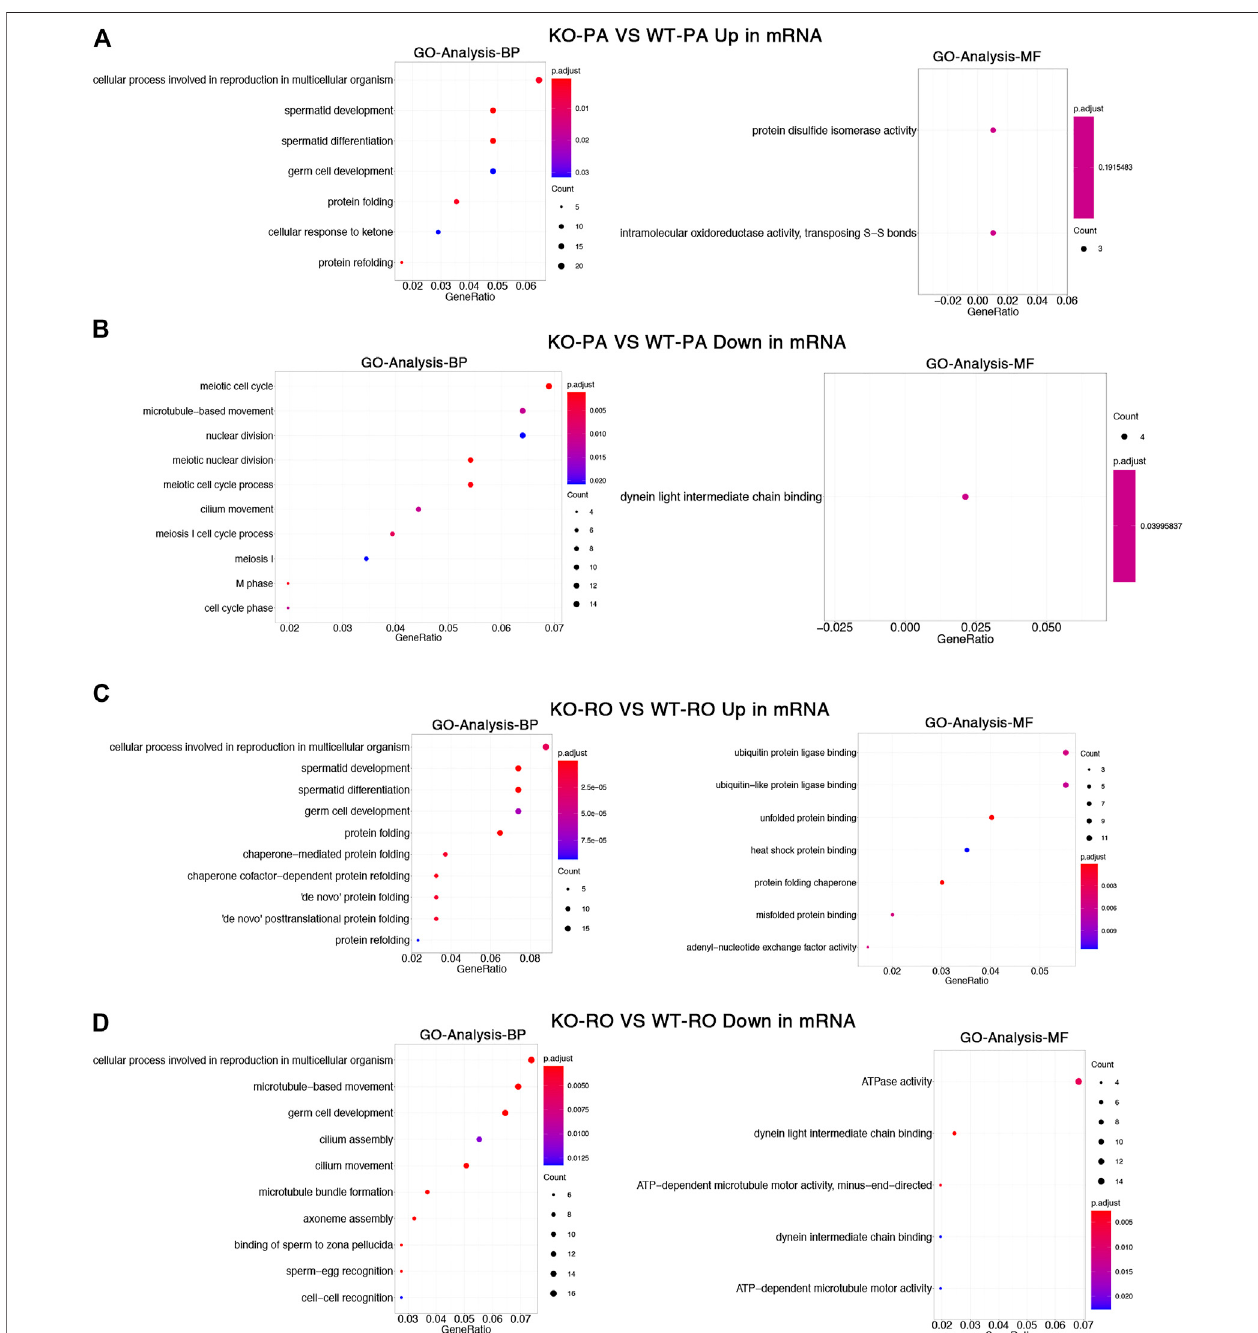
FIGURE5| GOenrichmentanalysisofupregulated (A) and downregulated (B) genesbetween Alkbh5 -KOPAand WTPA.GOenrichmentanalysisofupregulated (C) and downregulated (D) genes between Alkbh5 -KO RO and WT RO.